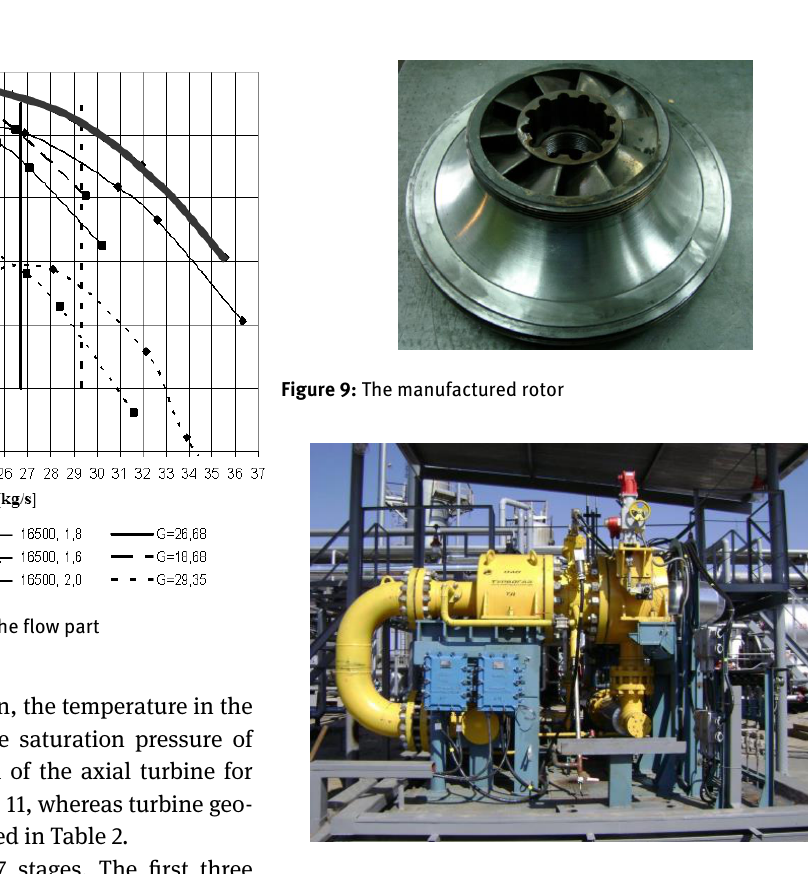
Figure 10. Expansion turbine MTDA-3,0-10,4-MP-U2 Figure 10: Expansion turbine Figure 9. The manufactured rotor